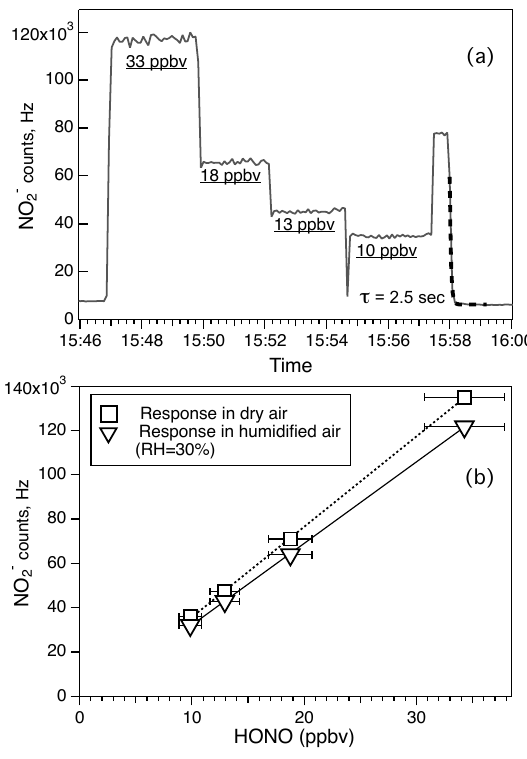
Fig. 4. The response of the NI-PT-CIMS to addition of the nitric acid standard directly before the ion flow tube. The nitric acid signal is shown in gray, the system response to removal of the nitric acid can be fit with a double exponential (dashed line). The signal in the nitrous acid channel (mass 46) is shown as open circles with the solid black line denoting the 60-s